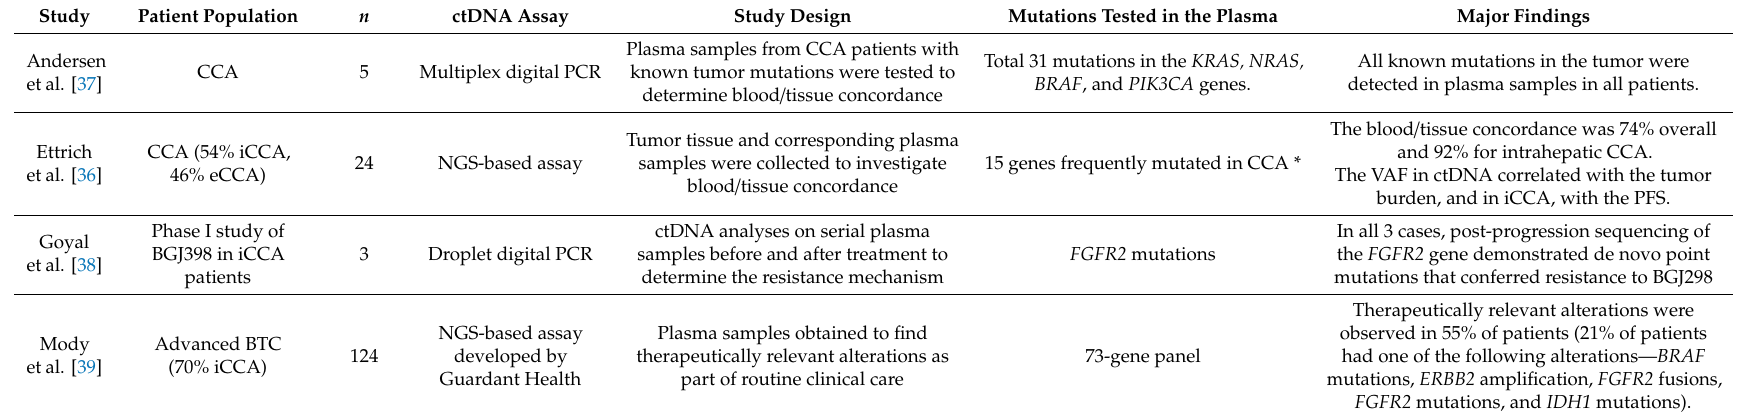
Table 2. Studies evaluating the clinical utility of circulating tumor DNA (ctDNA) in patients with advanced biliary tract cancer